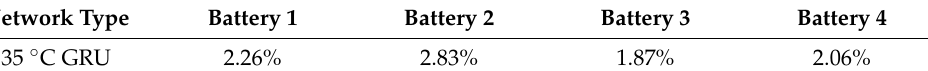
Table 12. Real-time SOC-estimation errors using the GRU model.